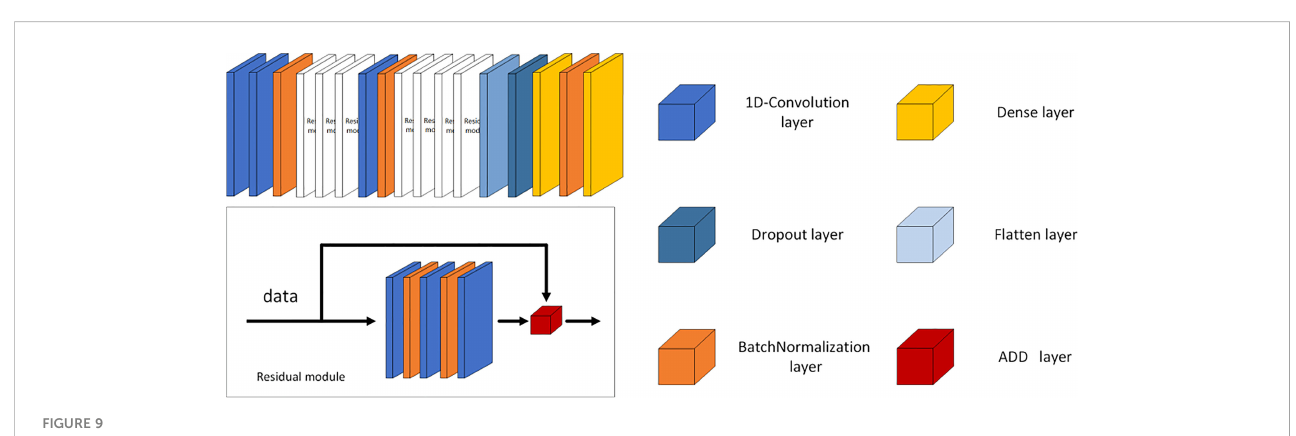
Figure 10B, 2:1 in Figure 10C, 1:1 in Figure 10D, and 1:2 in Figure 10E, respectively. In Figures 10, 11, the lines “ train-acc ” and “ train-loss ” are the results obtained in the training set, and “ val-acc ” and “ val-loss ” are the results obtained in the testing set.